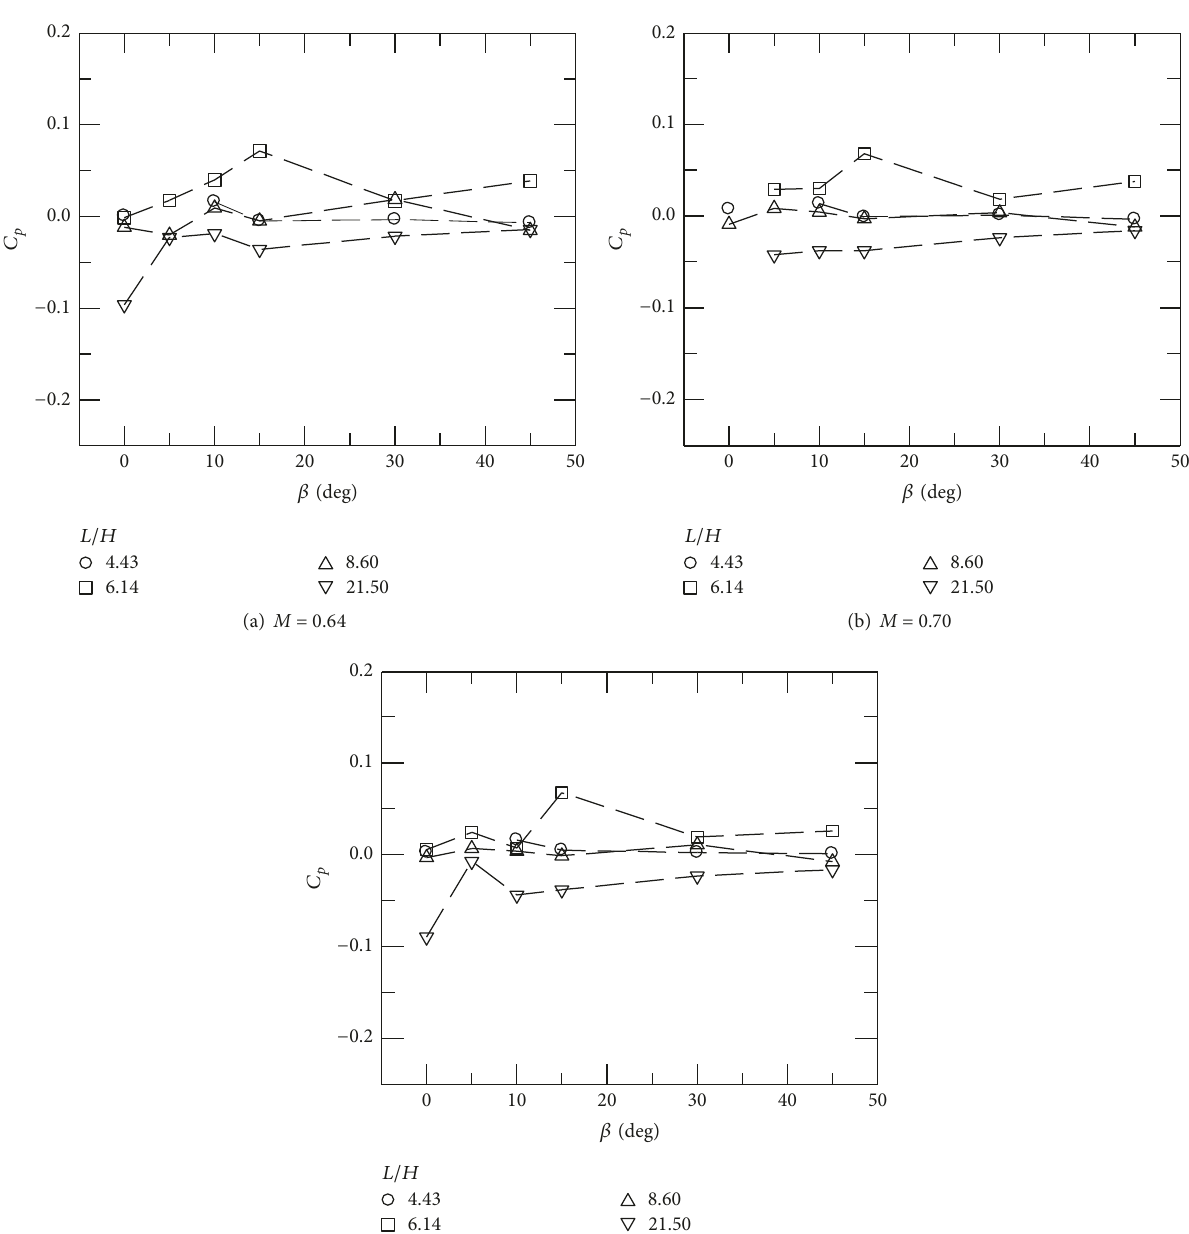
of 𝛽 near the rear face ( x/L = 0.919 and 1.058, which are, resp., labeled as hollow and solid symbols). The amplitude of 𝐶 𝑝 at x/L = 0.919 for a closed cavity ( L/H = 21.5) is greater than that for a transitional-open ( L/H = 8.60) or an open cavity ( L/H = 4.43 and 6.14). The value of 𝛽 has a more significant effect on the amplitude of 𝐶 𝑝 for a value of x/L = 1.058 than for a